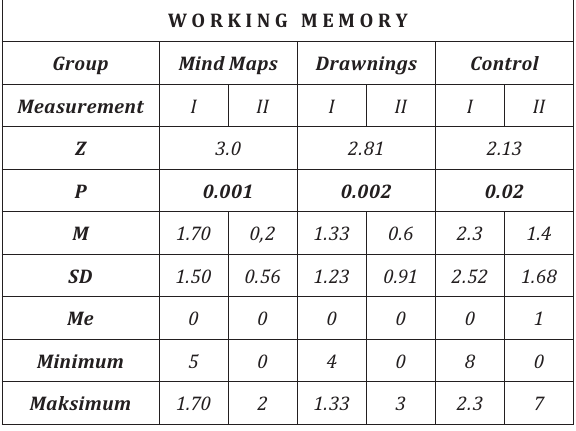
Table 2. Comparison of average results for the